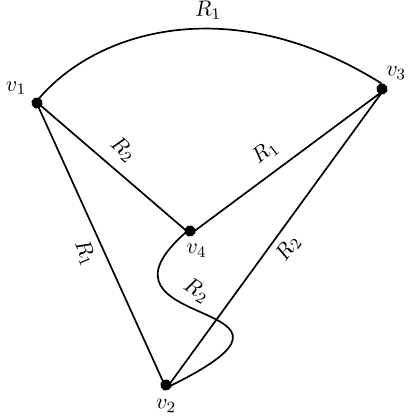
Figure 1. Graph Structure G ∗ = ( V , R 1 , R 2 ) Figure 1: Graph Structure G ∗ = ( V, R 1 , R 2 )